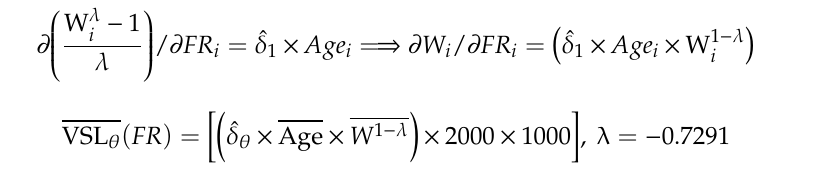
Table 4. The estimated value of statistical life by